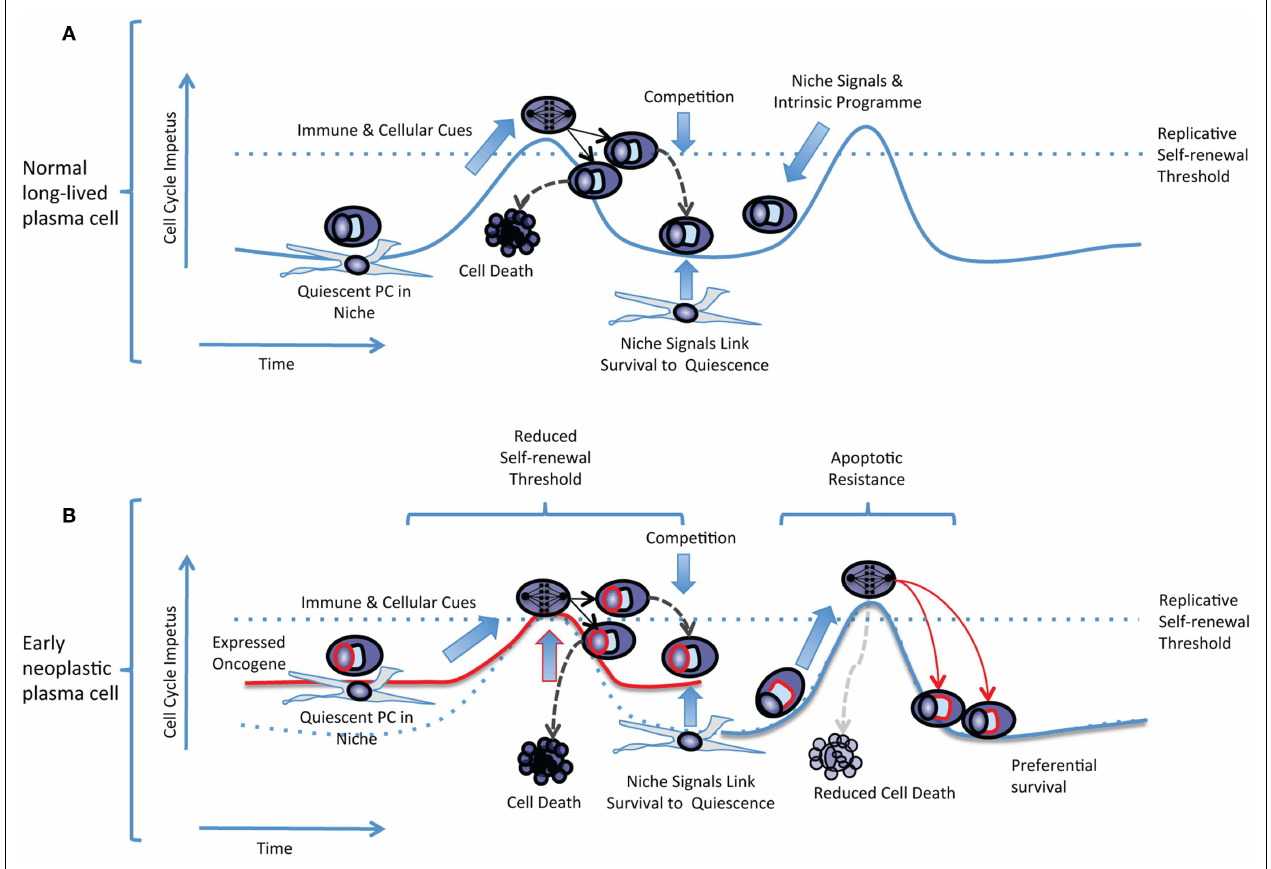
FIGURE 2 |The replicative self-renewal model of long-lived PC maintenance . (A) A normal quiescent plasma cell is illustrated residing in a niche environment.The replicative self-renewal threshold is illustrated as a dotted blue line running across a hypothetical curve representing the cell cycle impetus in the quiescent plasma cell.The vertical axis represents the cell cycle impetus and the horizontal axis represents time. Niche signals and the plasma cell intrinsic program combine to establish the quiescence threshold and oppose cell cycle re-entry. Immune and cellular cues intermittently overcome the self-renewal threshold, leading to entry into cell cycle, mitosis, and generation of daughter cells that compete for survival. Successful competition for niche survival signals is linked to the